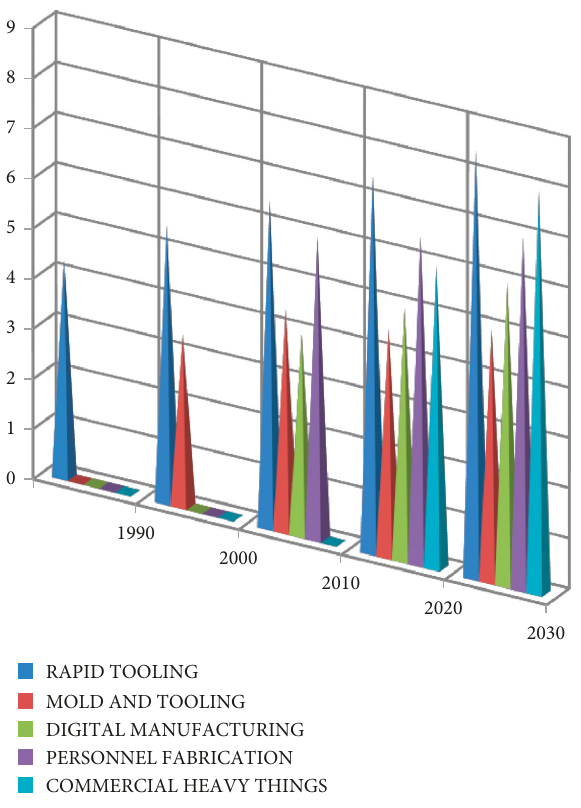
Figure 4: Adoption of AM up to 2021 [1, 2, 28, 29].